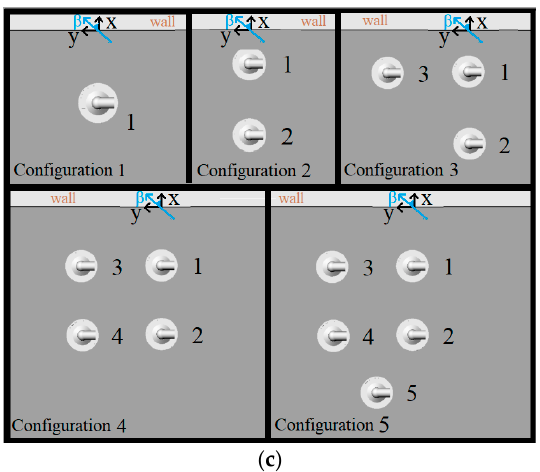
Figure 3. Schematic representations of the considered OWC array arrangements in front of a vertical breakwater and the numbering of the devices’ considered: ( a ) five examined configurations of OWCs arranged in parallel direction to the wall; ( b ) five examined configurations of OWCs arranged perpendicularly to the wall; ( c ) five examined configurations of OWCs arranged rectangularly to the wall.